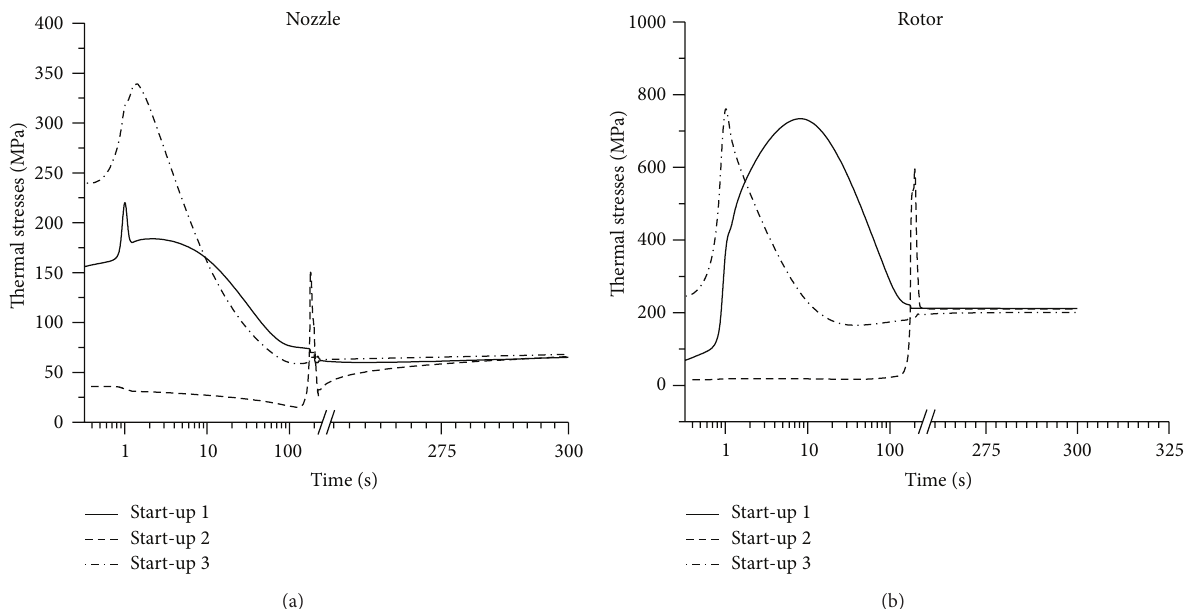
Figure 8: Highest thermal stresses variation on the components during start-ups.